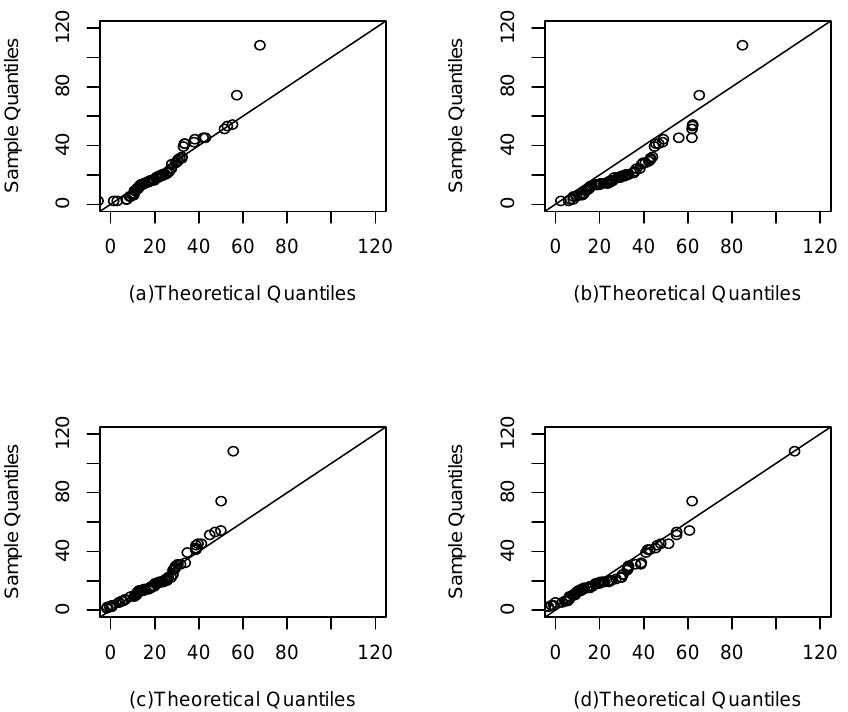
Figure 6. QQ plot for nickel concentration data set. The modified Laplace density ( a ), exponentially modified logistic density ( b ), exponentially modified Gaussian density ( c ), and exponentially modified Laplace density ( d ).